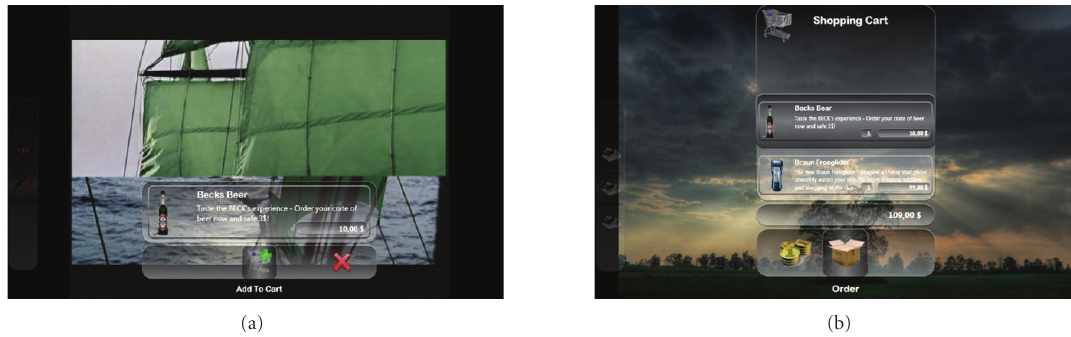
Figure 3: Personalized targeted advertisement with embedded shopping information (a) and shopping portal (b).